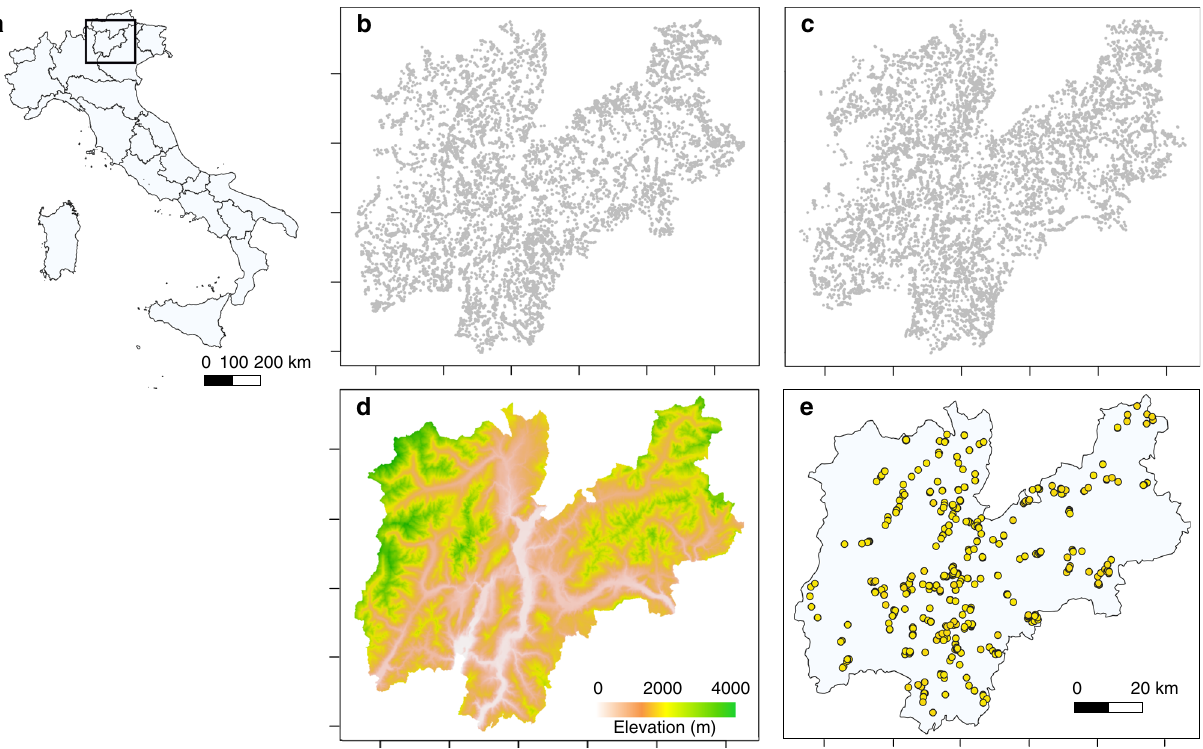
Fig. 1 Spatial location of orchid occurrence. a Location of the study area, b geographical distribution of the sites (grey points) over the fi rst period (1990 – 2003: n = 10,293) and c the second period (2004 – 2017: n = 11,308), d digital elevation model of the study area (resolution: 25 × 25 m) and e location of the 463 resurvey sites (yellow points).